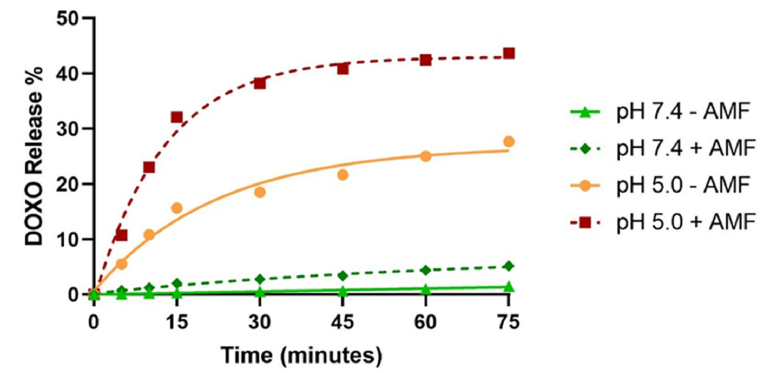
Figure 6. DOXO release percentage as a function of time measured with and without (AMF) at different pHs (7.4 and 5.0). The vertical error bars are smaller than the symbol.